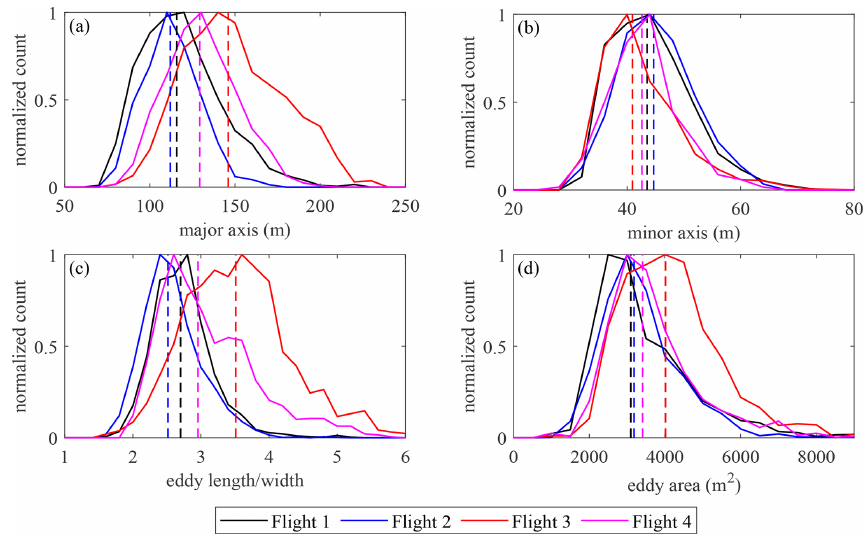
Figure 11. Distributions of size parameters of the eddy thermal traces derived from the 2D wavelet transforms. The vertical dashed lines mark the distribution medians. The major axis is the greater dimension of the coherent structure’s thermal trace (“length”), which is always oriented in streamwise direction; correspondingly, the minor axis is the “width”.